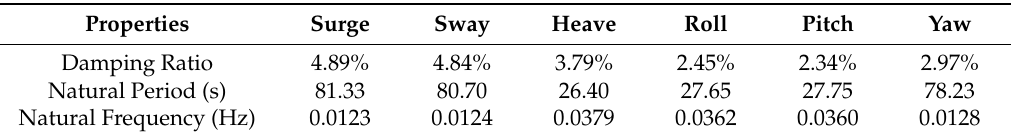
Table 5. Damping ratios and natural periods derived from FAST decay tests for the moored FOWT-SFFC without fishing